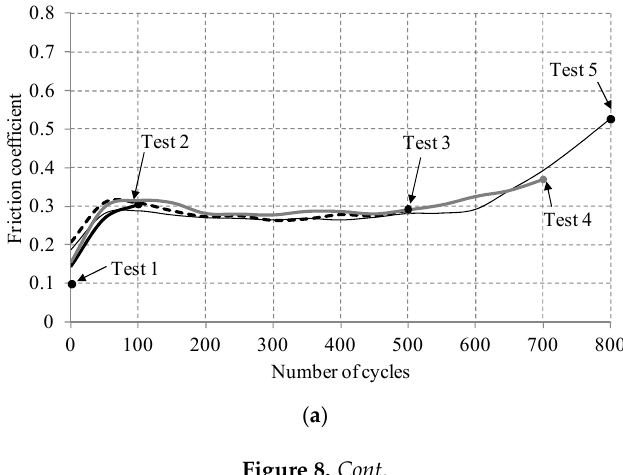
Figure 8. Cont. Figure 8. Cont